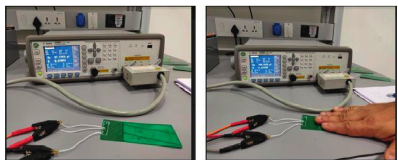
Figure 12: Capacitance measurement by the LCR meter.